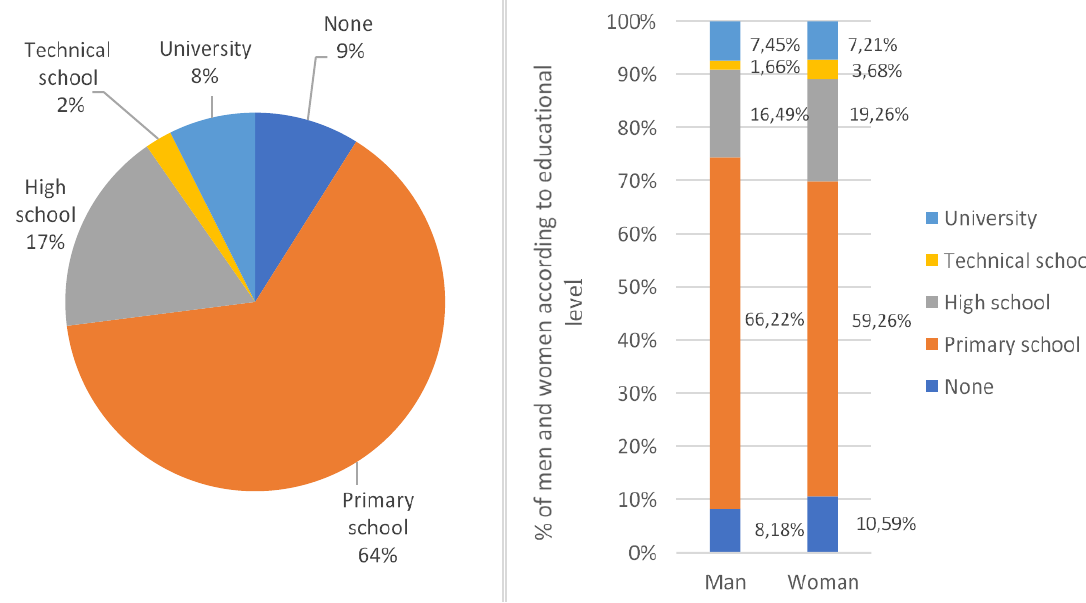
Figure 8. Educational level of the associates segregated by sex.